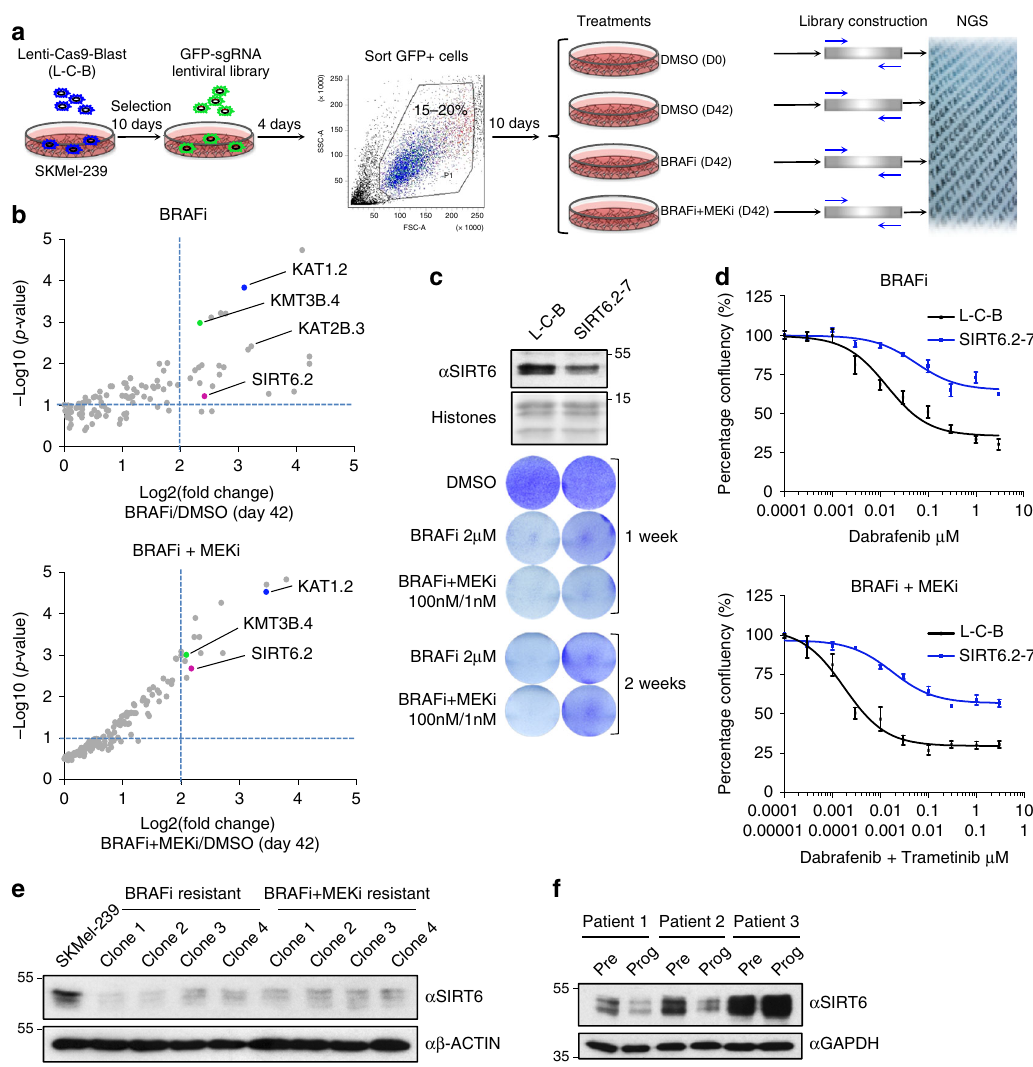
Fig. 1 CRISPR – Cas9 screen identi fi es SIRT6 as a determinant of melanoma drug resistance. a Schematic of the CRISPR – Cas9 screen for chromatin factors that regulate dabrafenib (BRAFi) and dabrafenib + trametinib (BRAFi + MEKi) resistance in SKMel-239 BRAF V600E melanoma cells. b Scatterplot of enrichment of sgRNAs after 6 weeks of BRAFi (top) or BRAFi + MEKi treatment (bottom). Genes in the upper right quadrant represent signi fi cant hits in each screen and those indicated in color represent signi fi cant hits present in both. c (Top) Immunoblot of SIRT6 in the indicated whole-cell lysate samples in SKMel-239. Histones used as a loading control. L-C-B and SIRT6.2 – 7 cells were seeded at the same density and cultured in DMSO or in the presence of the MAPKi as indicated for 1 or 2 weeks. d Growth inhibition curves are shown for BRAFi (top), as well as BRAFi + MEKi (bottom) at 72 h of treatment ( n = 3). Data are mean ± SEM. e . Immunoblot of SIRT6 in the indicated whole-cell lysates of SKMel-239 or MAPKi-resistant clones generated after continuous exposure to the indicated drugs. B-Actin was used as a loading control. f Immunoblot of SIRT6 in the indicated whole-cell lysates of patient- derived short-term cultures (STCs; matched samples before vemurafenib treatment (Pre) and upon disease progression (Prog)). GAPDH was used